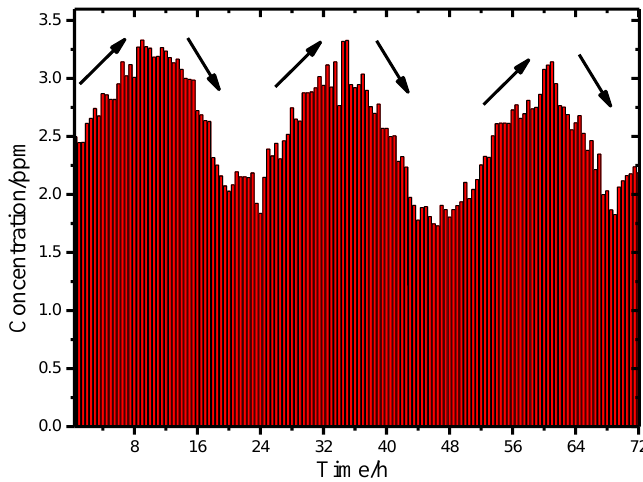
Figure 8. Recorded values for the CH 4 concentrations.